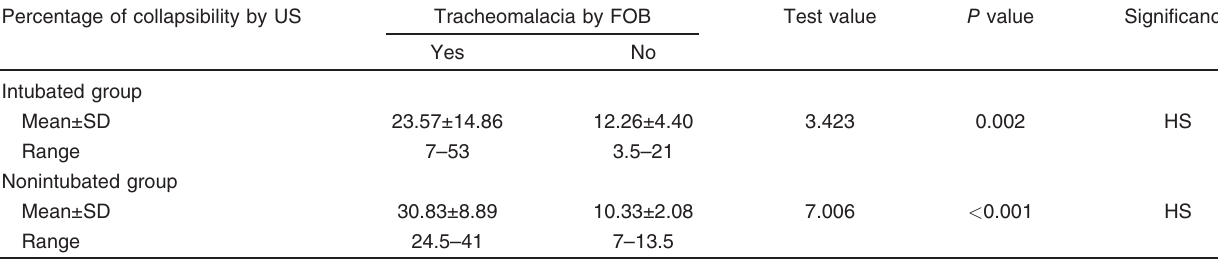
Table 12 Comparison between percentage of collapsibility by ultrasound and tracheomalacia by dynamic expiratory computed tomography Percentage of collapsibility Tracheomalacia by dynamic expiratory CT